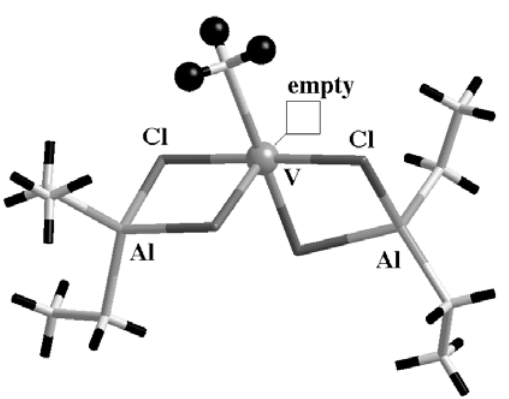
Figure 6. The V-based homogeneous catalyst proposed as an active center. Four Cl atoms bridge V and the Al atoms of the ligand, and the geometry of the site closely resembles the octahedral Corradini Ti site on the (110) surface of MgCl (see text for details). Only the H atoms of the methyl group, rep- 2 resenting the direction of the growing polymer, have been evidenced as black balls; other H are the black sticks.